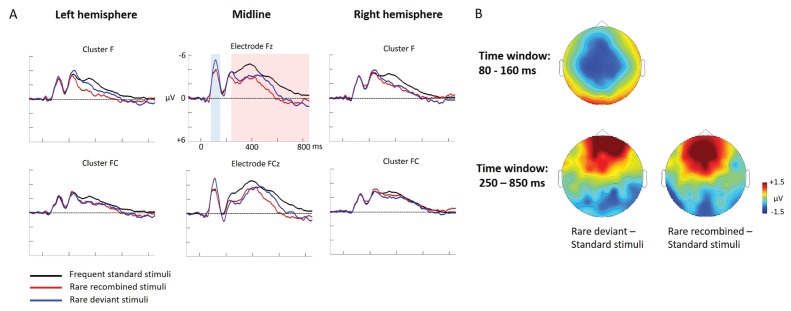
Grand average ERPs of Experiment 2b.(A) ERPs to the three conditions (‘Frequent standard stimuli’, ‘Rare recombined stimuli’, ‘Rare deviant stimuli’) are superimposed for the electrode clusters F and FC, and the electrodes Fz and FCZ. The analyzed time epochs are marked in blue (80–160 ms) and red (250–850 ms). (B) The topographical distribution of the difference ‘Rare deviant stimuli’ minus ‘Frequent standard stimuli’ and ‘Rare recombined stimuli’ minus ‘Frequent standard stimuli’ for the first and second time window.